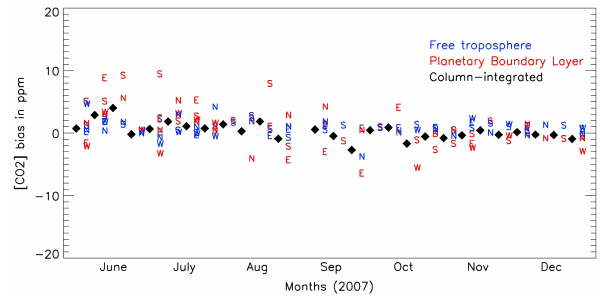
Fig. 5. CO 2 concentration differences between the observed CO 2 concentrations by the aircraft and simulated by CT v 09 at the four aircraft sites (indicated by the cardinal directions) in the Planetary Boundary Layer (in red), the free troposphere (in blue), and column-averaged PBL (black diamonds).